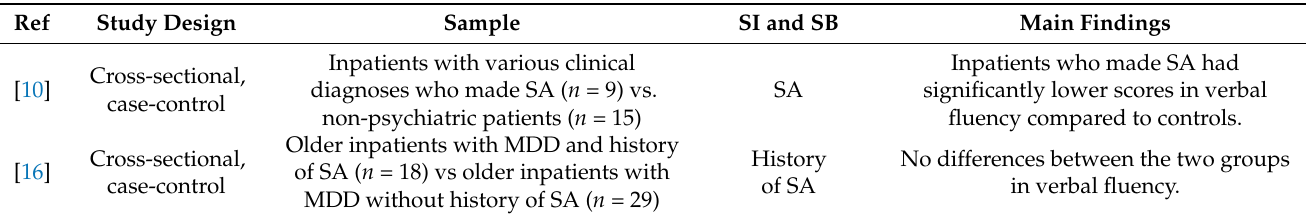
Table 2. Studies investigating the neuropsychological profile in suicidal patients (with a particular focus on language-related functions when summarizing their main findings